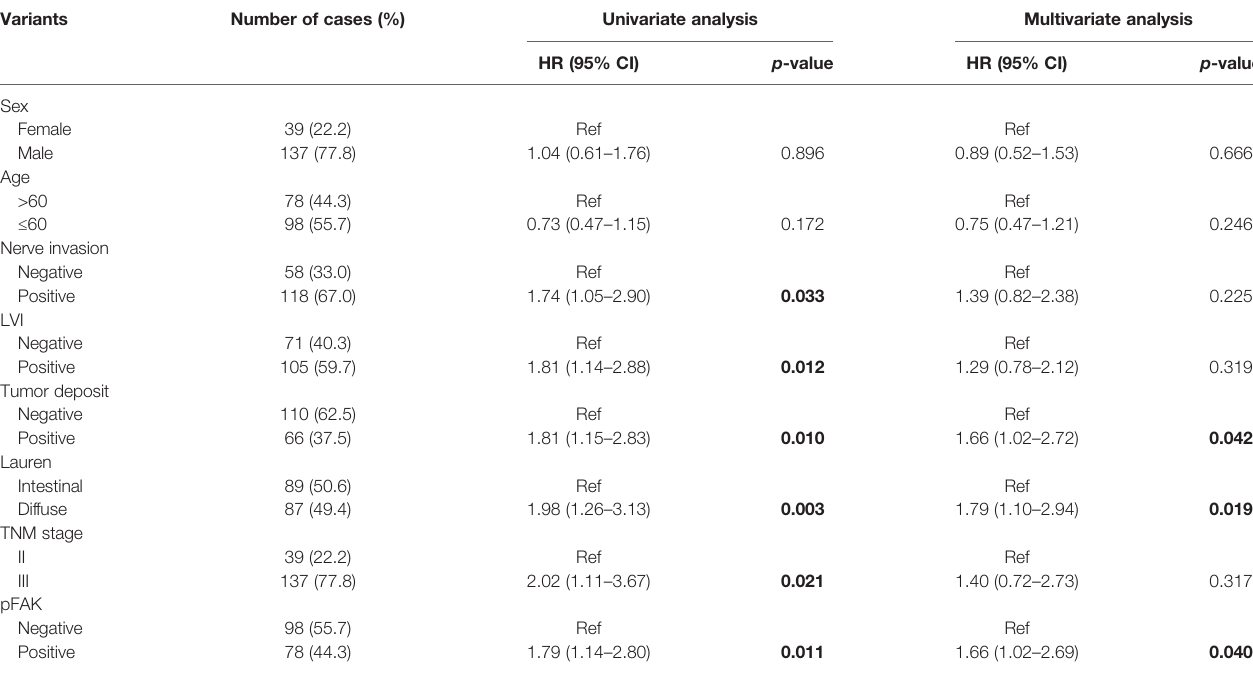
TABLE 2 | Univariate and multivariate Cox analysis of clinicopathological factors associated with the survival in GCs. Variants Number of cases (%) Univariate analysis Multivariate analysis HR (95% CI) p -value HR (95% CI) p